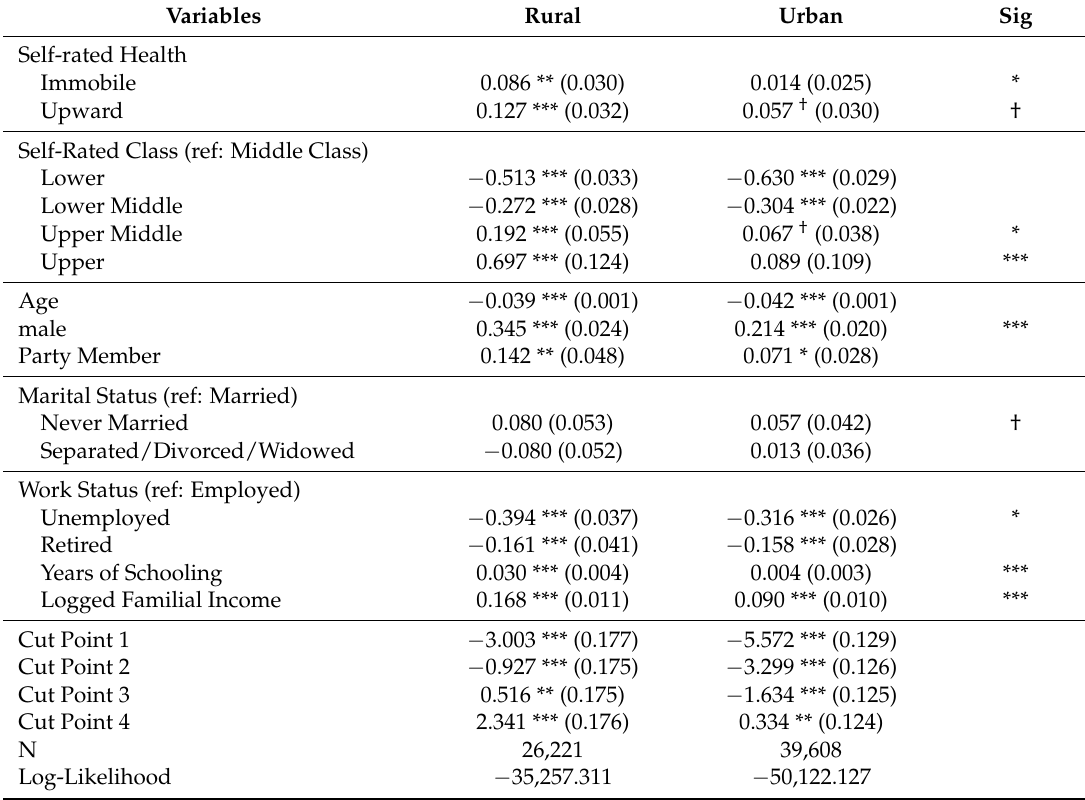
Table 4. Ordered Logit Model Predicting Self-Rated Health by Residence